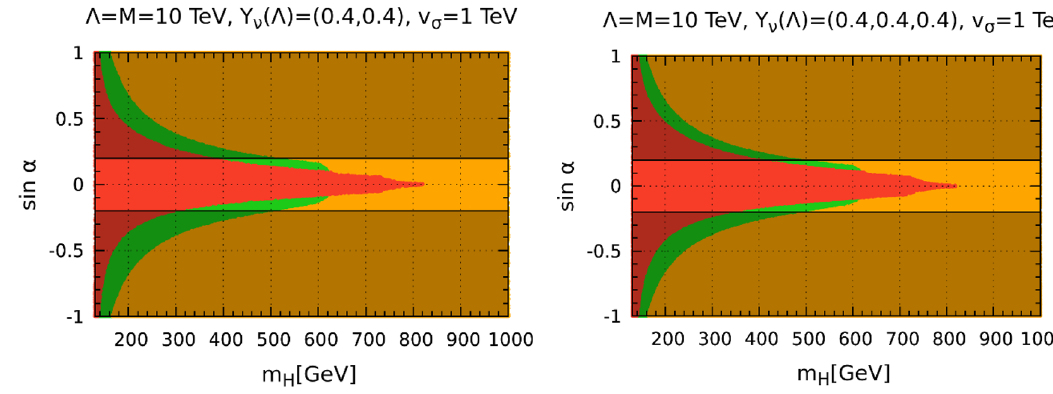
Figure 13 . Vacuum consistency constraints of figure 12 for the case of (3,2,2) (left) and (3,3,3) (right) inverse majoron seesaw mechanism. The diagonal entries of the Y ν matrix are fixed as Y ii = 0 . 4 . See ν